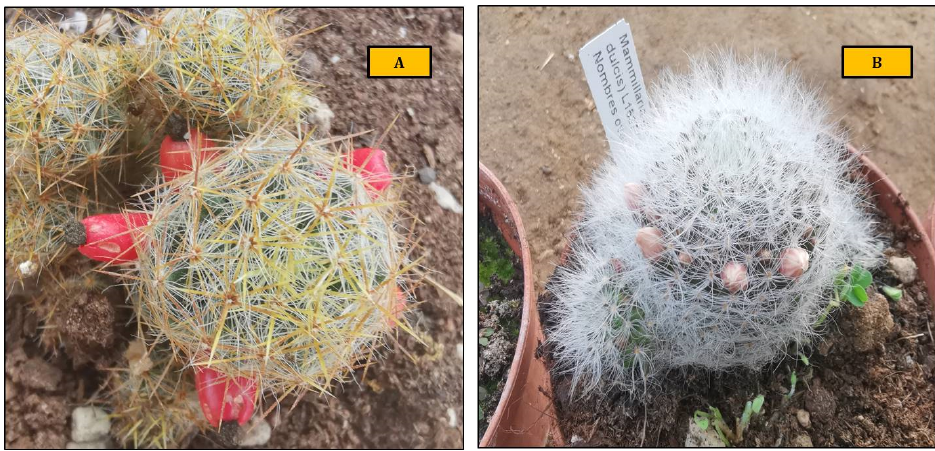
Figure 1. A view of Mammillaria prolifera ( A ) and Mammillaria glassii ( B ) plants in CREA-OF greenhouses.